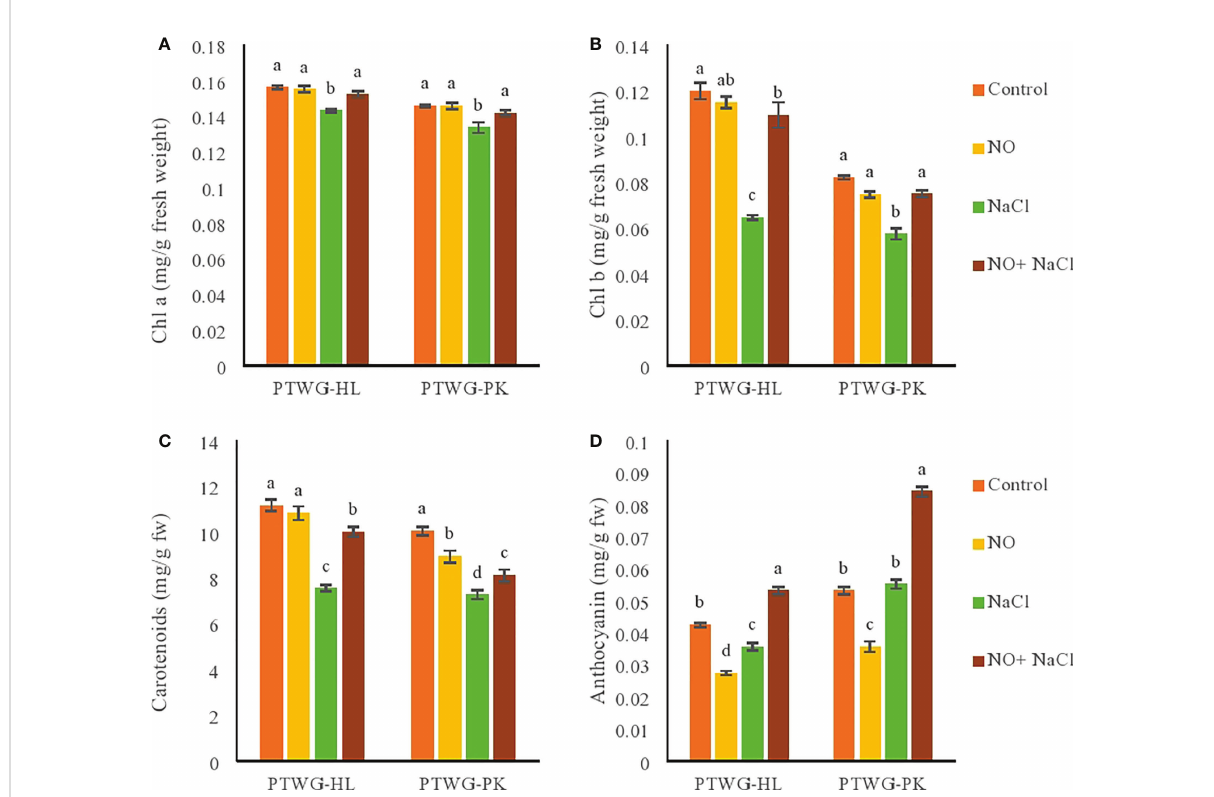
FIGURE 2 Shows chlorophyll a, chlorophyll b, carotenoids and anthocyanin contents of forty-two days old ecotypes of turnip ( Brassica rapa L.) under sodium chloride and nitric oxide stress. (A) Chlorophyll a, (B) Chlorophyll b, (C) Carotenoids, (D) Anthocyanins. Means with the same letters on each bar do not differ signi fi cantly at the 5%